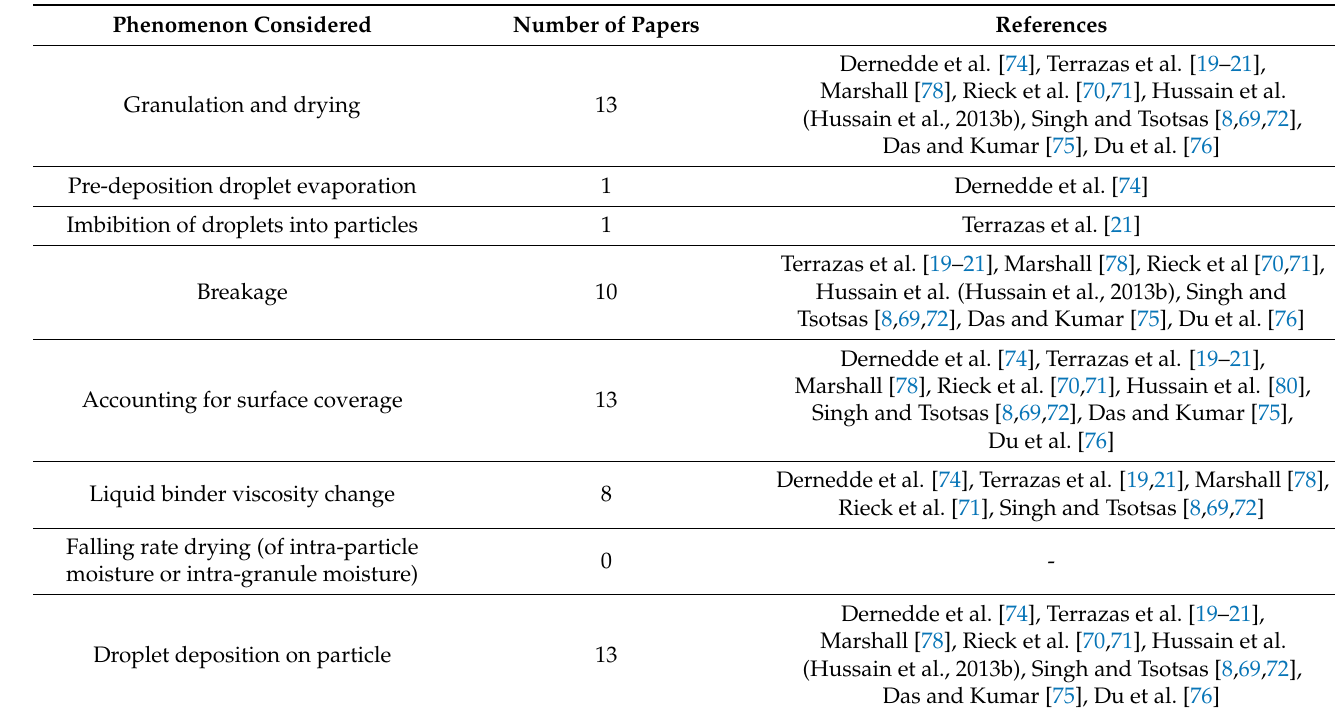
Table 4. Phenomena involved in the fluid bed granulation which need to be addressed in stochastic modeling